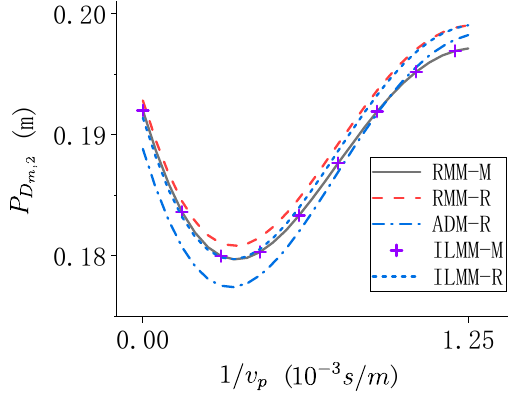
Figure 15. The variation of the mean peak response of D m ,2 with respect to 1/v p , when di ff erent Figure 15 . The variation of the mean peak response of (cid:1830) (cid:3040),(cid:2870) with respect to 1/v (cid:2926) , when different modelling methods are used. modelling methods are used